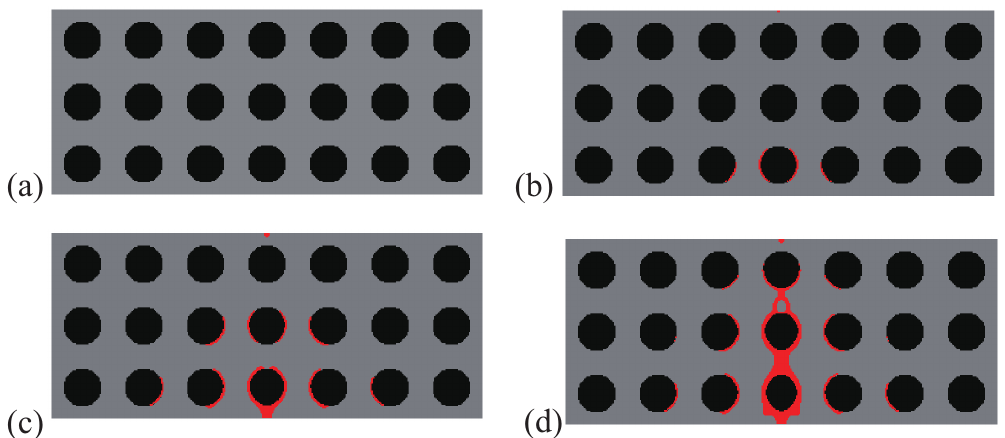
Figure 4. Crack propagation in the periodic composite subjected to three-point bending, initial design: